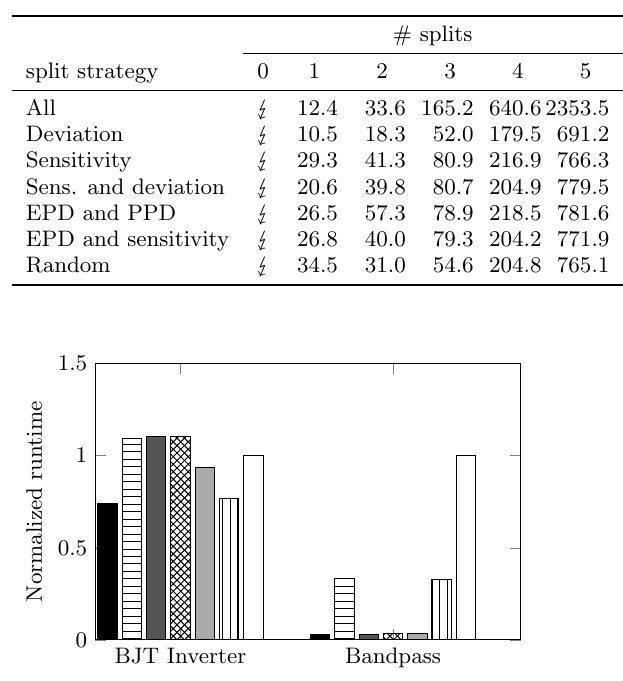
Figure 14: Number of splits and runtime versus deviation for S 1 , parameter deviations given in Table 1 are scaled with factor v , split strategy = All Table 4: Simulation runtime in seconds for dif- ferent number of splits (forced independently of splitting criterion) and different split strategies for S 1 , means that convergence was not achieved in (cid:32) 30 iterations